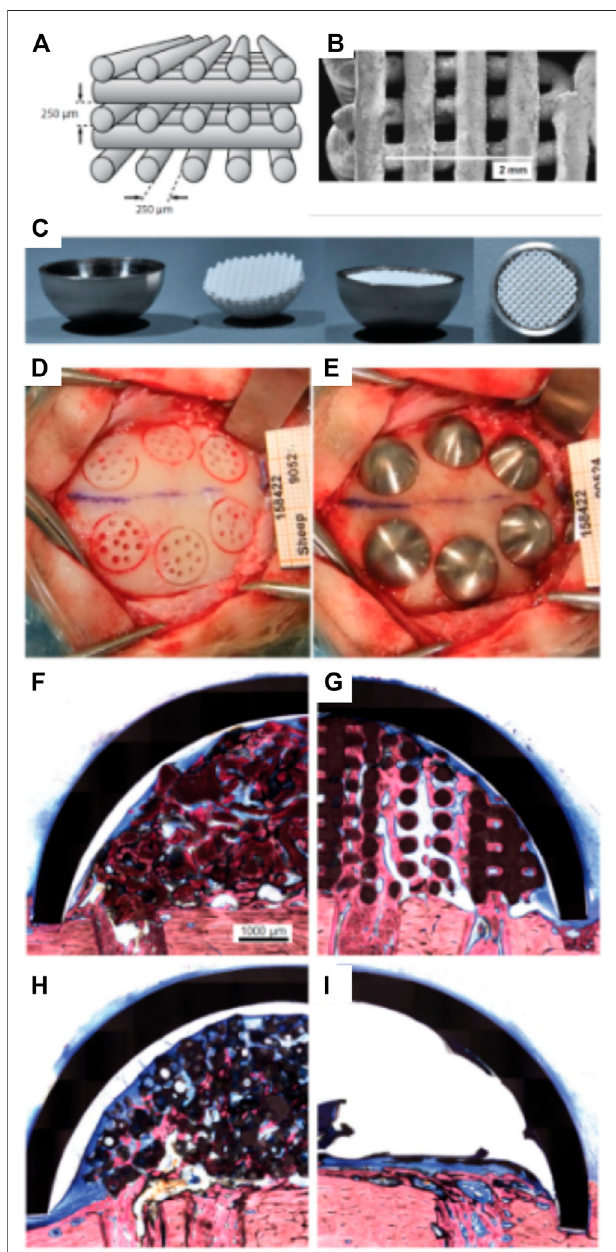
FIGURE 4 | Bio-ceramic scaffold manufacturing via direct extrusion printing. (A) : Schematic representation of the 3D-printed Osteo fl ux bio- ceramic, (B) : Morphology of the 3D-printed scaffold as imaged using Scanning Electron Microscopy. (C) : implantation system featuring a titanium dome acting as an occlusive barrier. (D) : Preparation of the implantation site using a sheep extraskeletal model. (E) : pictures of the implanted domes containing the various groups. (F – I) histology of the specimen at 8 weeks post-implantation demonstrating the excellent bone forming ability of the 3D-printed scaffold (F) : Bio-Oss, (G) : 3D-printed Osteo fl ux, (H) : Ceros, (I) : empty dome (blood clot). Reproduced with permission from (Carrel et al.,